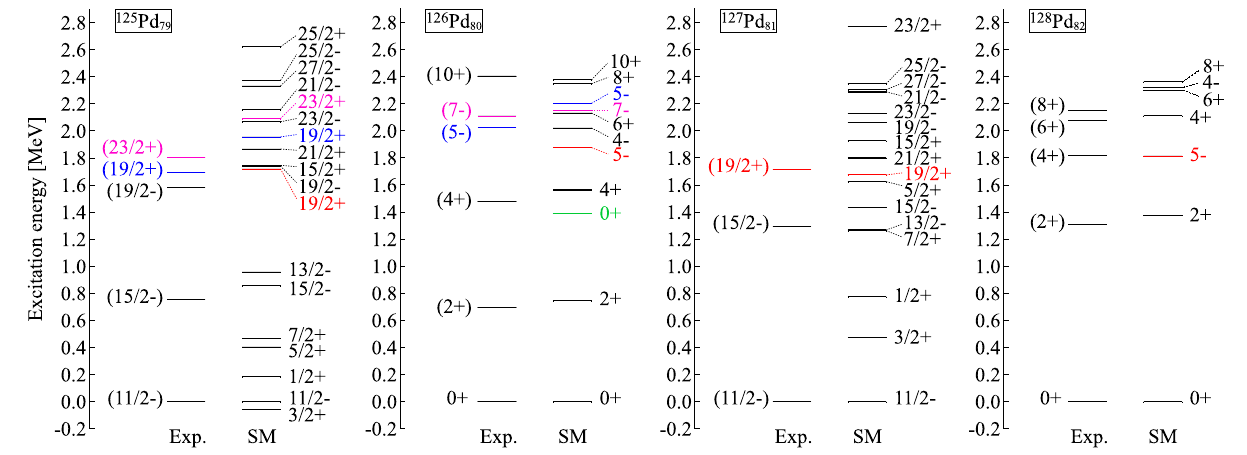
Figure 5. Comparison between experimental and shell-model (SM) level energies in 125 , 126 , 127 , 128 Pd isotopes.